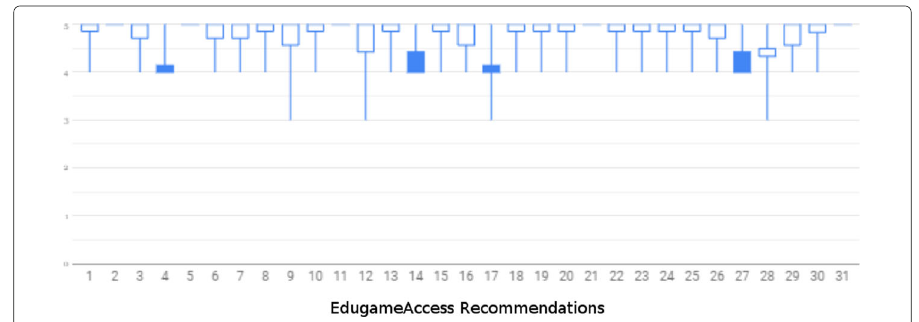
Fig. 7 Boxplot chart - Specialists grades using EduGameAccess